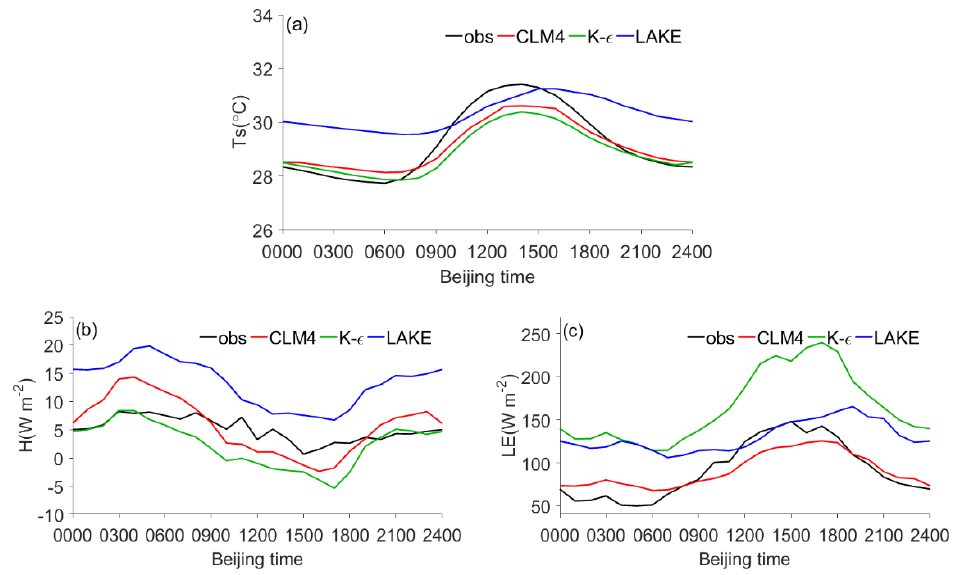
Figure 8. Comparison of simulated and observed diurnal variations of monthly mean surface temperature( a ), Sensible heat ( b ) and latent heat ( c ).